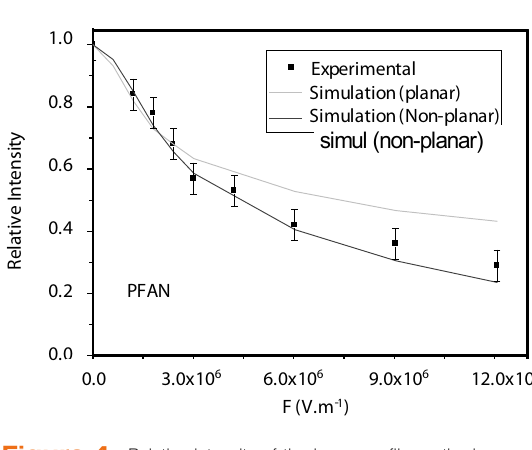
Figure 3. Geometry diagram for the PFAN non-planar model, showing the three principal axes ( a , b and c ).